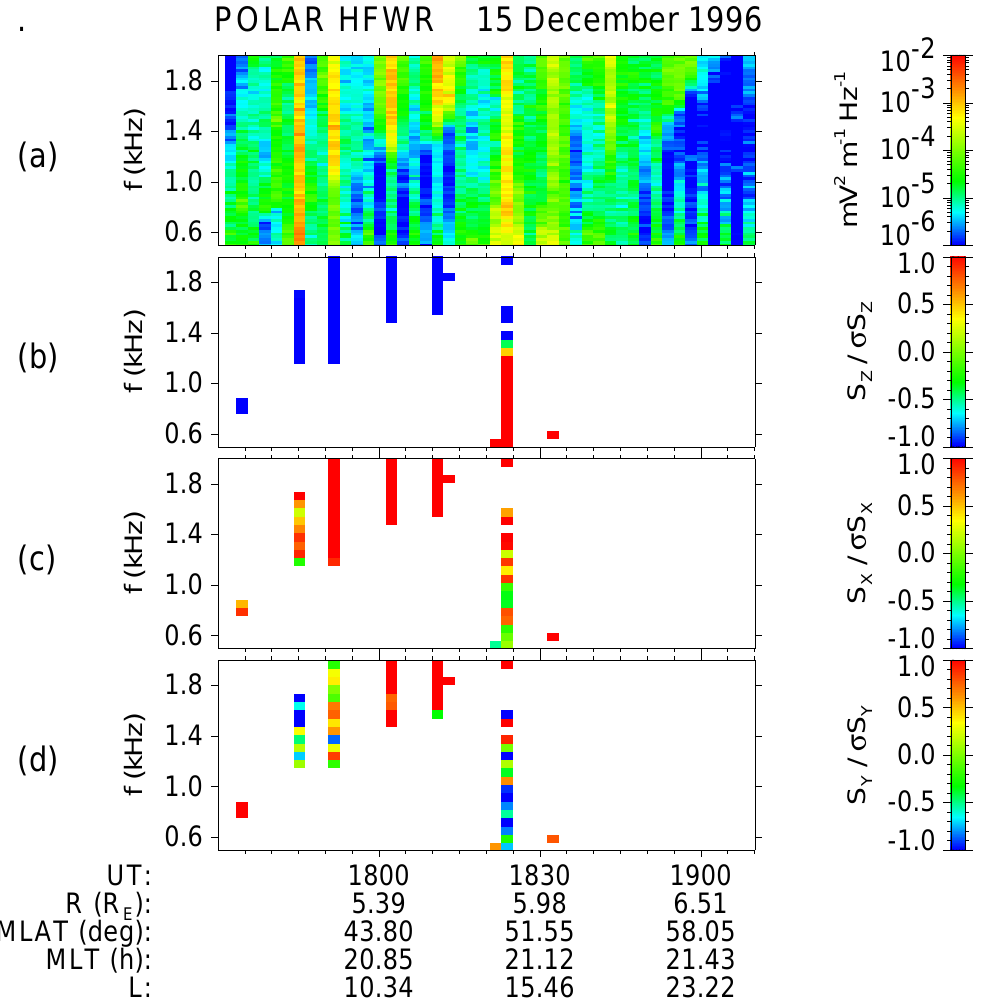
Fig. 8. Results of analysis of the multicomponent waveform measurement of the HFWR instrument on board the POLAR spacecraft. (a) Time-frequency power spectrogram of the electric field fluctuations. (b–d) Estimations of the three components of the Poynting flux normalized by their standard deviations in the coordinate system defined by the local stationary magnetic field B 0 using the method